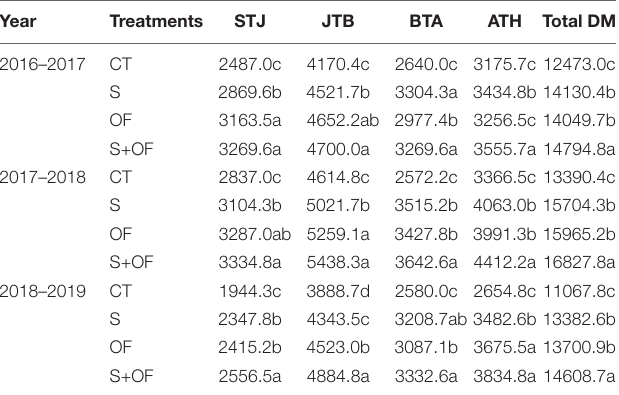
TABLE 1 | Effects of subsoiling, organic fertilizer and subsoiling combined with organic fertilizer on the dry matter accumulation (DM) at different growth stages of winter wheat in the three seasons of